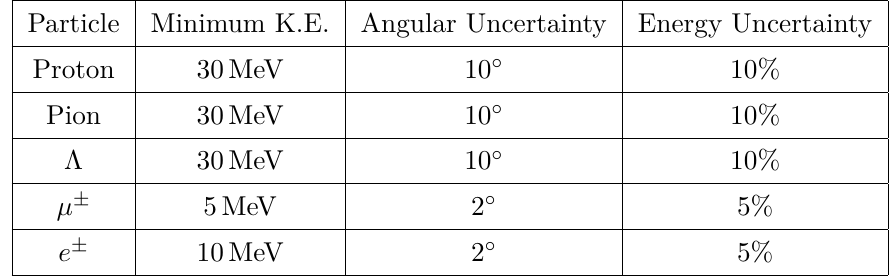
Table 1 . Assumptions of DUNE Far Detector reconstruction and identification capability that enter our